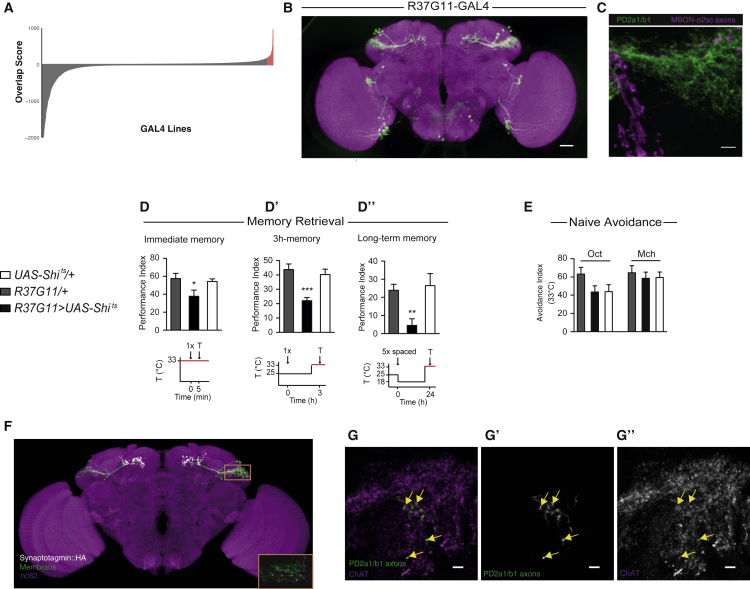
PD2a1 and PD2b1 Are Postsynaptic to MBON-ɑ2sc and Necessary for Memory Retrieval(A) Distribution of LH overlap scores for MBON-ɑ2sc axon mask versus 3,500 GAL4 lines. Scores > 97 percentile are labeled in red, y axis clipped <−2,000.(B) Sparsest GAL4 line labeling cell type PD2a1 and PD2b1, R37G11-GAL4 (image from https://www.janelia.org/gal4-gen1). Scale bar, 30 μm.(C) z-projection of double labeling. MBON axons are labeled in magenta, and PD2a1 and PD2b1 are labeled with membrane-bound GFP (in green). This LexA line contains both MBON-ɑ2sc (dorsal) and MBON-α′3ap (ventral). Scale bar, 5 μm. The image is representative of n = 4.(D–D”) Flies with R37G11-GAL4 driving Shits and genotypic controls were trained and tested with the illustrated protocols (restrictive temperature indicated in red). Silencing PD2a1 and PD2b1 neurons impaired immediate memory after single-cycle training (D; n = 12–13, F(2,36) = 3.79, p = 0.033), 3-hr memory after single-cycle training (D’; n = 9, F(2,26) = 12.07, p = 0.0002), and long-term memory after spaced training (D”; n = 9, F(2,26) = 6.28, p = 0.0064).(E) Flies expressing Shits driven by the 37G11-GAL4 driver showed normal olfactory avoidance to octanol (Oct) and methylcyclohexanol (Mch) compared with their controls at the restrictive temperature (Oct, n = 14, F(2,41) = 2.41, p = 0.10; Mch, n = 14, F(2,41) = 0.23, p = 0.79). Data are presented as mean ± SEM.(F) Confocal z-projection of PD2a1 and PD2b1 driving both membrane-bound GFP (green) and Synaptotagmin-HA (gray). PD2a1 and PD2b1 has been manually segmented. The orange rectangle represents the inset. Inset: a single slice of PD2a1 and PD2b1 dendrites showing punctate Synaptotagmin-HA, indicating dendritic presynapses. The image is representative of n = 5.(G–G”). ChAT immunohistochemistry demonstrating that PD2a1 and PD2b1 neurons are cholinergic. The images show a representative slice (n = 4 stacks). Scale bars, 5 μm.See also Figures S1–S3.